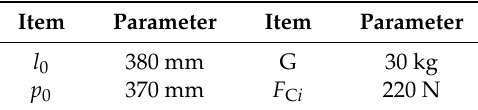
Table 4. System optimization